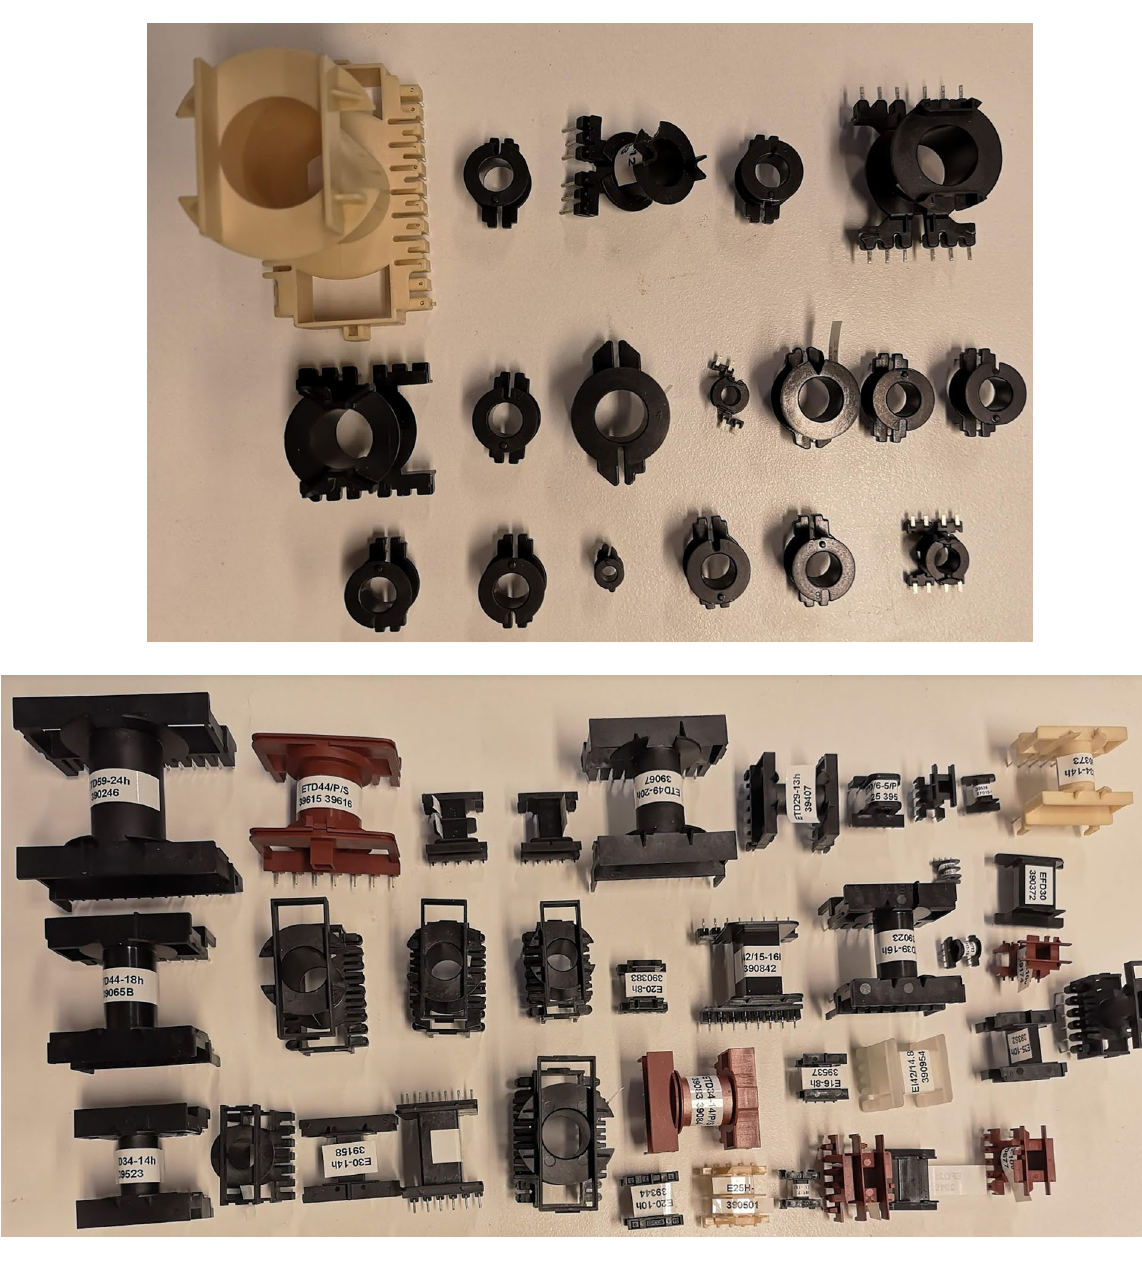
Fig. 7. Dividing parts according to the gripping surface